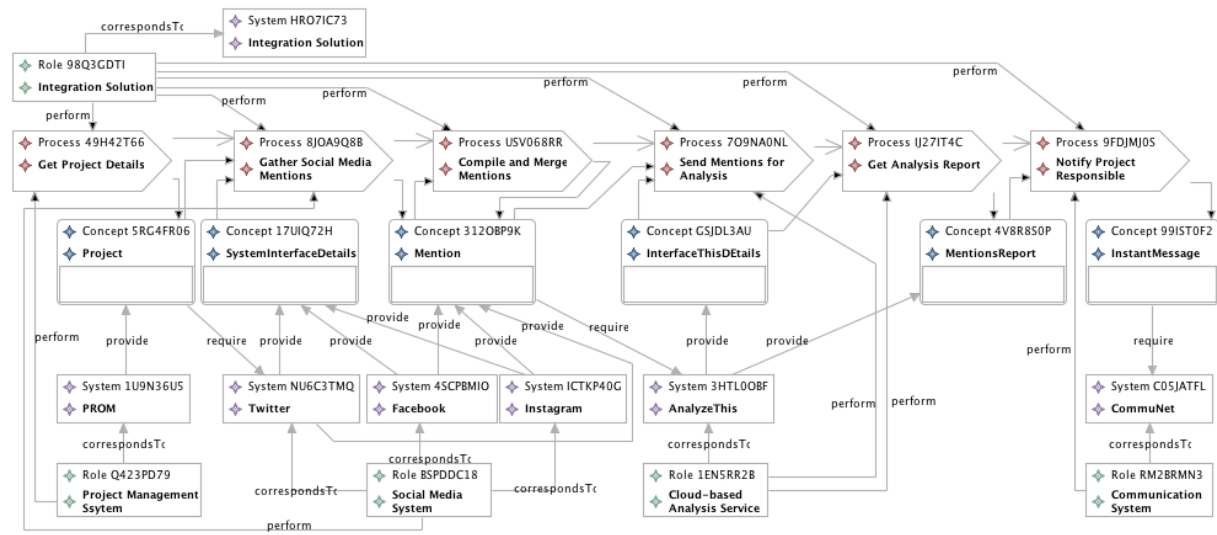
Figure 8. Concepts model of the integration solution for the case of Aid&More